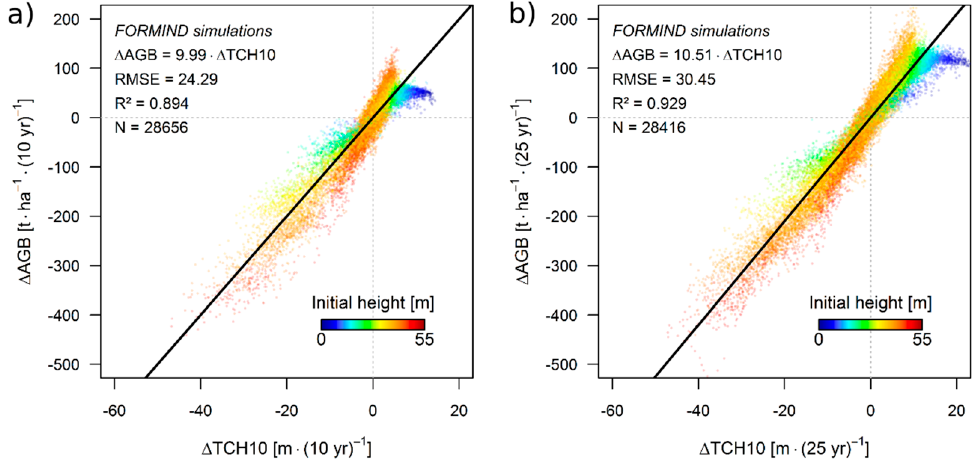
Figure A2. Simulated data showing the Δ TCH10-to- Δ AGB relationship for ( a ) a 10-year and ( b ) a 25-year time interval between first and second measurement. Each point represents a 1 ha forest-stand. Colors indicate the initial height (TCH10) of each stand. The black line represents the linear regression model.